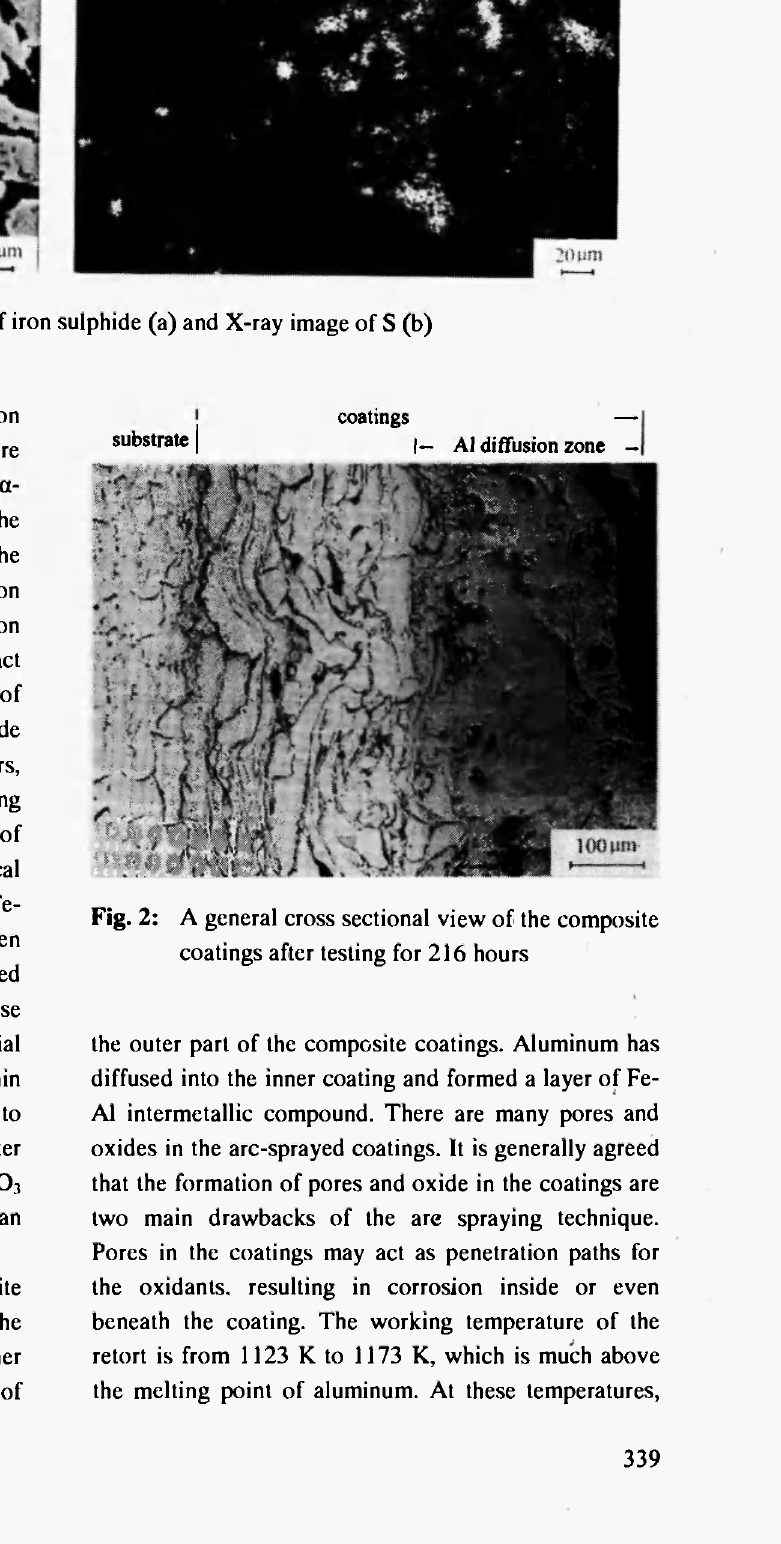
Fig. 1: Cross sectional view of iron